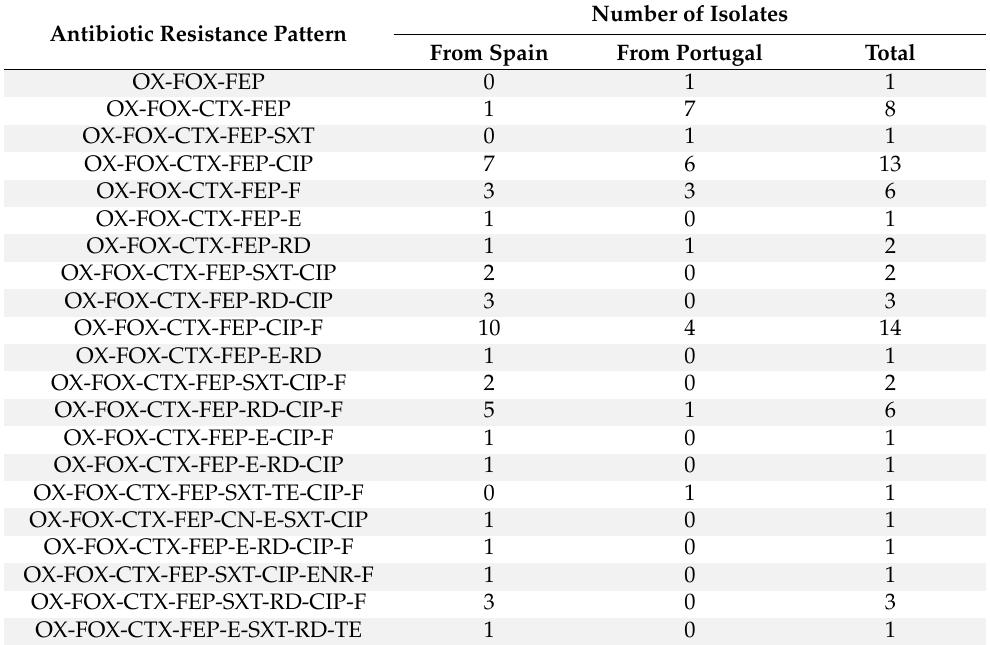
Table 3. Antibiotic resistance patterns shown by 70 isolates of Listeria monocytogenes from Spanish and Portuguese minced chicken samples. Number of Isolates Antibiotic Resistance Pattern From Spain From Portugal Total OX-FOX-FEP 0